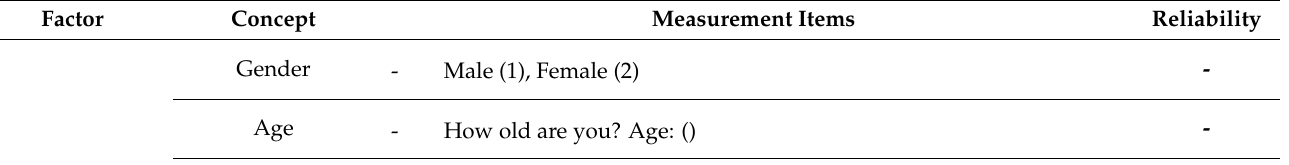
Table 3. Concepts, measurement items, and the scale’s